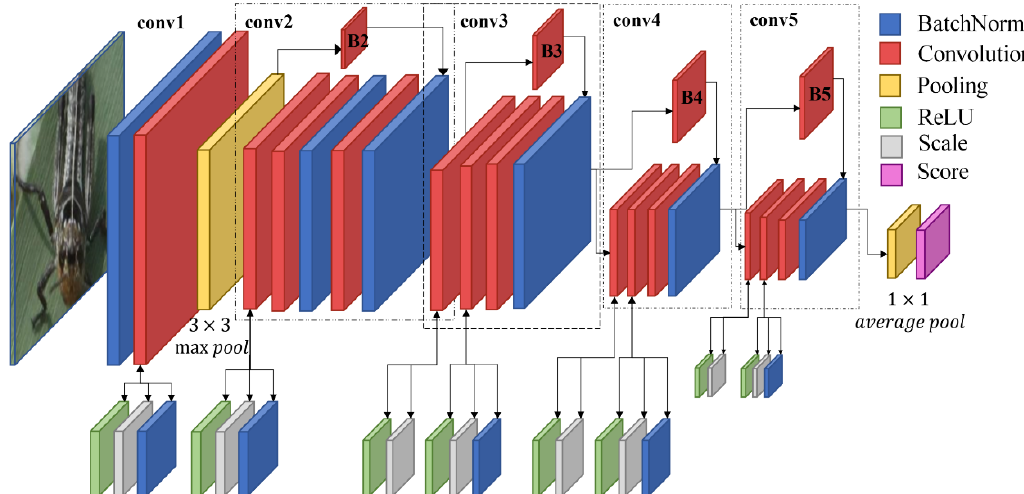
Figure 3. The logical structure of the ResNet-Locust-BN network. Note: Conv1-5 presents five groups of primary convolution process with different parameters and number of iterations. Convolution parameters in sequence of : conv1 is [7×7 (kernel size), 64 (channels number), s(stride) = 2, p(pad) = 3];